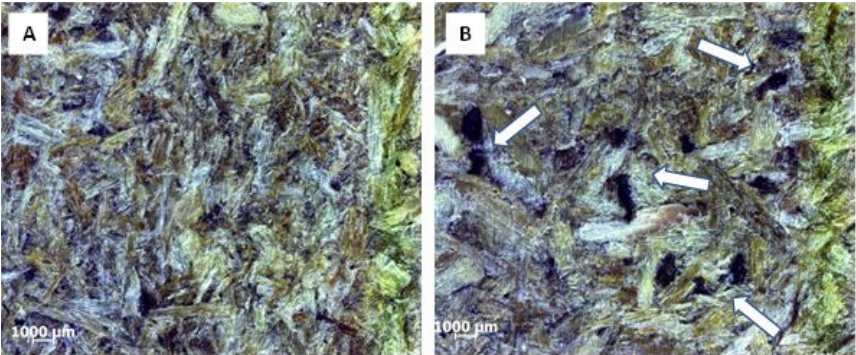
Figure 3. Micrographs of raw ( A ) and sanded ( B ) surface of particleboard at 40× magnification. Wood dust-resin spots are unavoidable in commercial particleboard production, as the specific area of wood dust particles is rather large thus leading to the formation of unfavourable agglomerates of dust-covered with an extensive amount of glue (resin) mixture. Wood dust particles are, however, required in industrial particleboard production, as they fill the gaps between individual particles (strands) of the outer layer, thus contributing greatly to the formation of water diffusion barrier [54,55]. IR heating treatment of particleboard caused an increased value of all roughness parameters (except Rsk) compared to roughness of raw particleboard. The differences are significant for the parameters Ra, Rz and Rt, and R sm . It is possible that, due to the heating at 50 ◦ C, moisture evaporated from the core layers to the surface layers, which caused an increase in roughness. The roughness measurements result of re-pressed particleboard are not so clear as some parameters after re-pressing were reduced (Ra and Rz) and some parameters were almost unchanged (Rt, Rv, and Rsm) compared to row particleboard. In contrast, almost all roughness parameters of re-pressed OSB (except Rsm) were higher compared to raw OSB, but these differences were not statistically significant. This increase in roughness could be caused by water escaping from the inner layers to the surface of OSB due to the re-pressing process. In addition, IR treatment reduced the surface roughness of OSB compared to the untreated surface, but the differences in values were also not significant. The results of water absorption for particleboard and OSB, depending on the expo- sure time and surface treatment of the panel, are given in Figure 4. Apart from the fact that the water absorption of each of the examined test samples groups rose with the ex- tension of the time of exposure, additional conclusions could be made. Sanding of parti- cleboard and OSB samples increased water absorption, which is almost certainly the result of permanent removal of protective, hydrophobic (wax) layer from the surface of test sam- ples, accompanied with complete removal of wood dust-resin spots from the parti- cleboard surface (Figure 3B). The pressure of 0.8 MPa is not enough to cause a major in- crease in density of tested particleboard and OSB (0.3% on average) and consequent re- duction in water absorption. Therefore, the increase in water absorption of particleboard and OSB after re-pressing can be also related to the removal of a protective, hydrophobic (wax) layer from the surface caused by a high temperature (120 °C) during re-pressing.